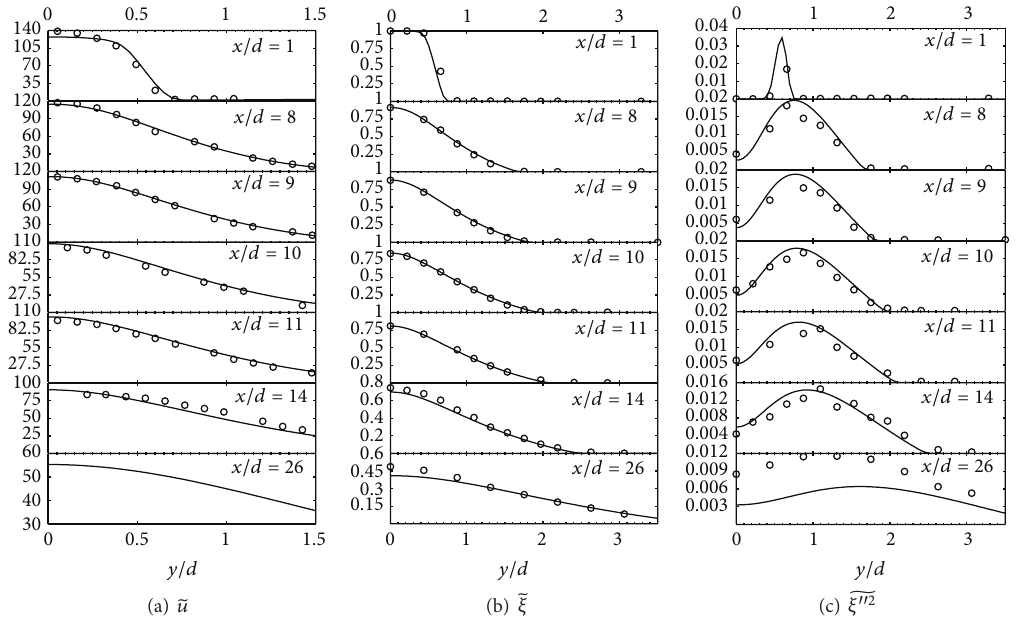
̃𝜉 󸀠󸀠2 ̃𝜉 , and (c) . Lines, numerical results; symbols, experimental data ( ̃𝑢 obtained from [44] and